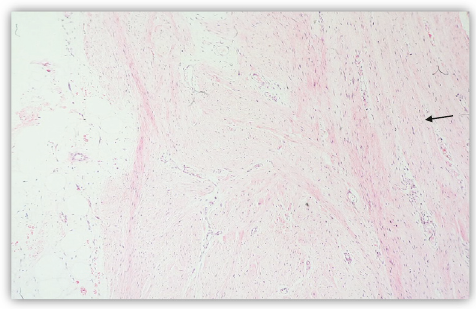
Figure 4: Mature Adipose tissue (arrow). H & E stain (100x).